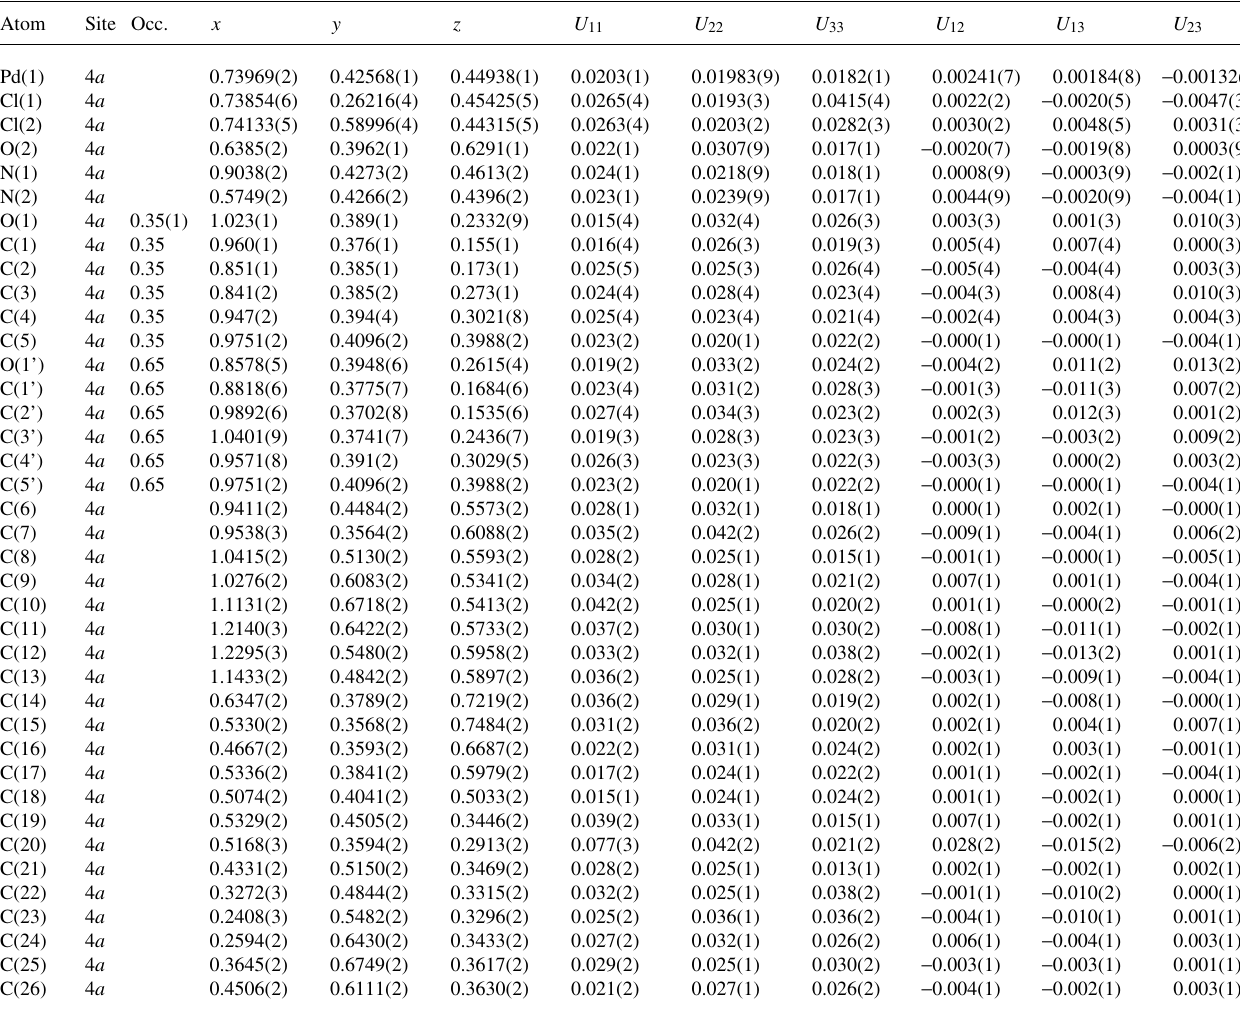
Table 3. Atomic coordinates and displacement parameters (in Å 2 ) . Atom Site